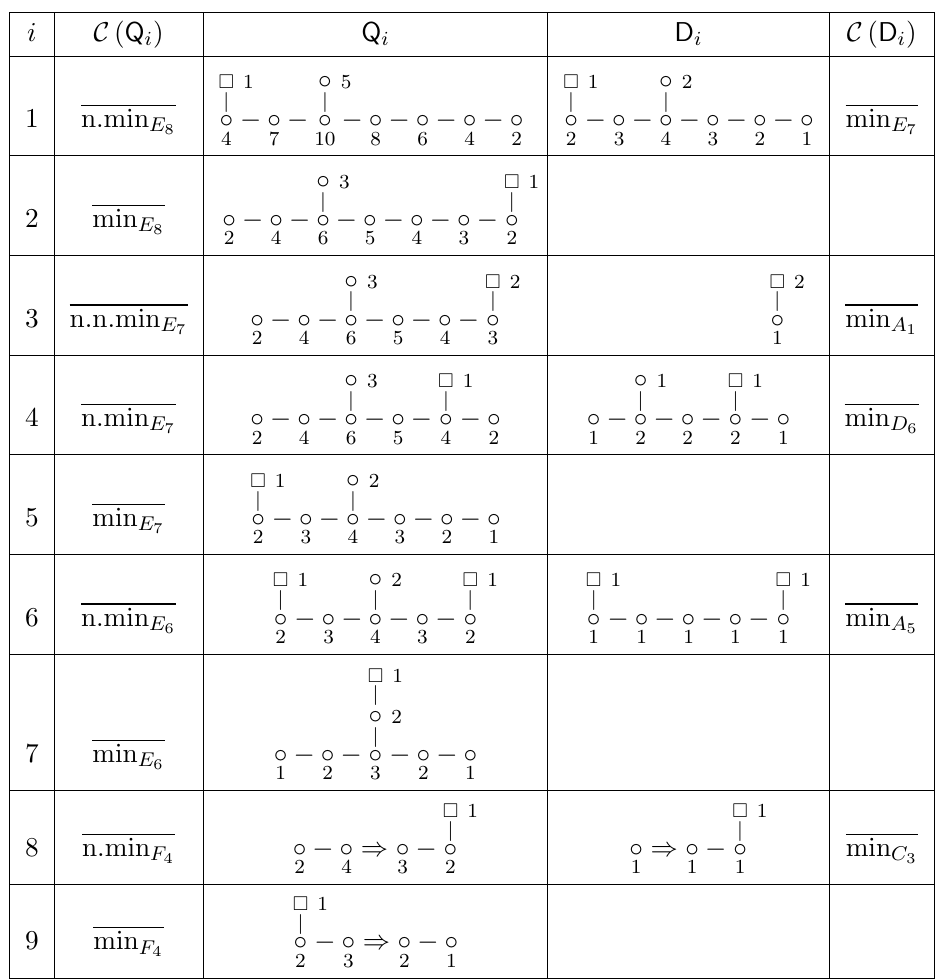
Table 1 . Kraft-Procesi transitions between closures of nilpotent orbits of exceptional Lie algebras. min G denotes the closure or the minimal nilpotent orbit of Lie ( G ). Similarly, we use n : min G for the next to minimal nilpotent orbit and n : n : min G for the next orbit in dimension after the next to minimal. The subtraction quiver D i := Q i (cid:0) Q i +1 is computed and its Coulomb branch C ( D i ) corresponds to the transverse slice between Q i and a point in the interior of Q i +1